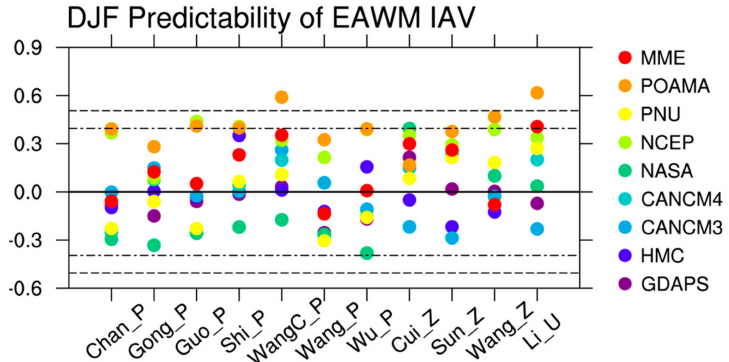
Figure 2. The temporal correlation coefficients between the observed and simulated normalized DJF-mean EAWM indices for the period 1983–2007. Dashed lines denote the threshold values for the 95% and 99% significance